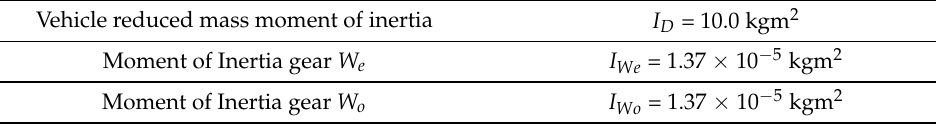
Table A4. Moment of